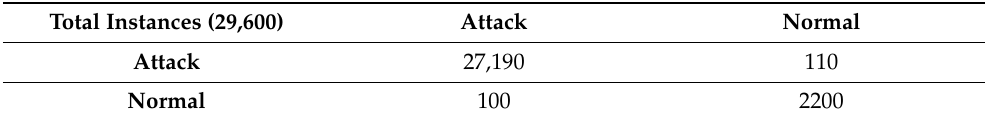
Table 5. Training confusion matrix of KNN.